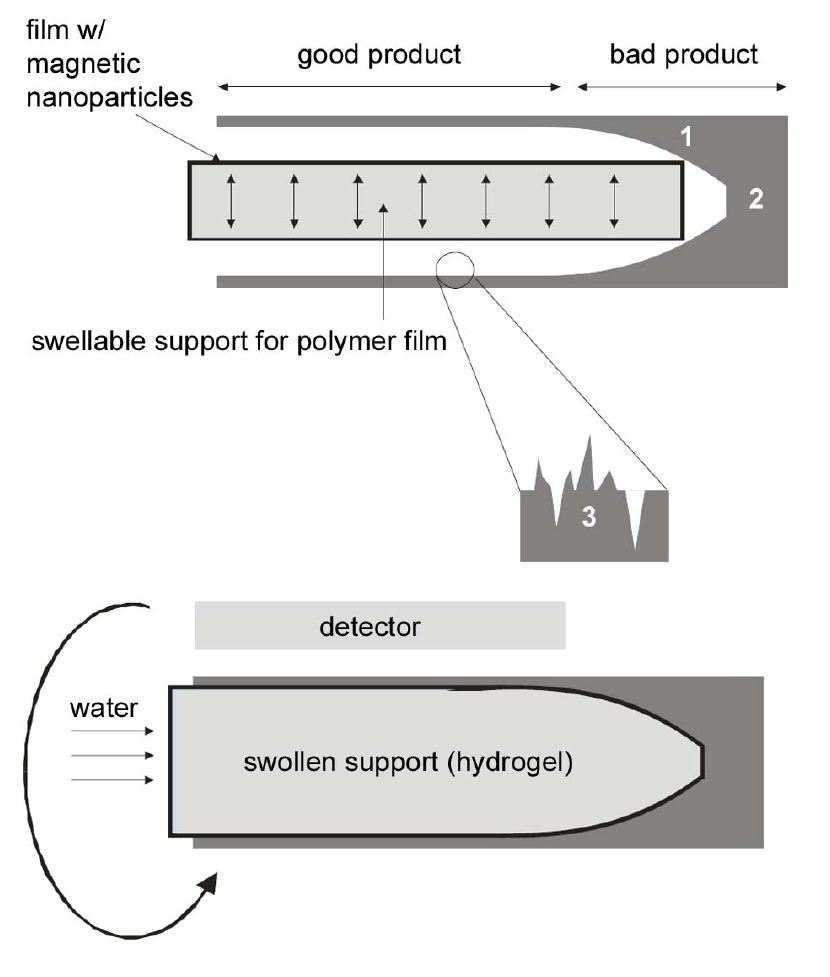
Scheme 1 . Schematic of the concept for mapping the inner surface of small NiTi tubes. (top) A dry hydrogel surrounded by an elastic polymer film containing magnetic nanoparticles (MNPs) is introduced into the tube. (bottom) The gel is swollen by the addition of an appropriate swelling agent and the MNPs embedded in the film are